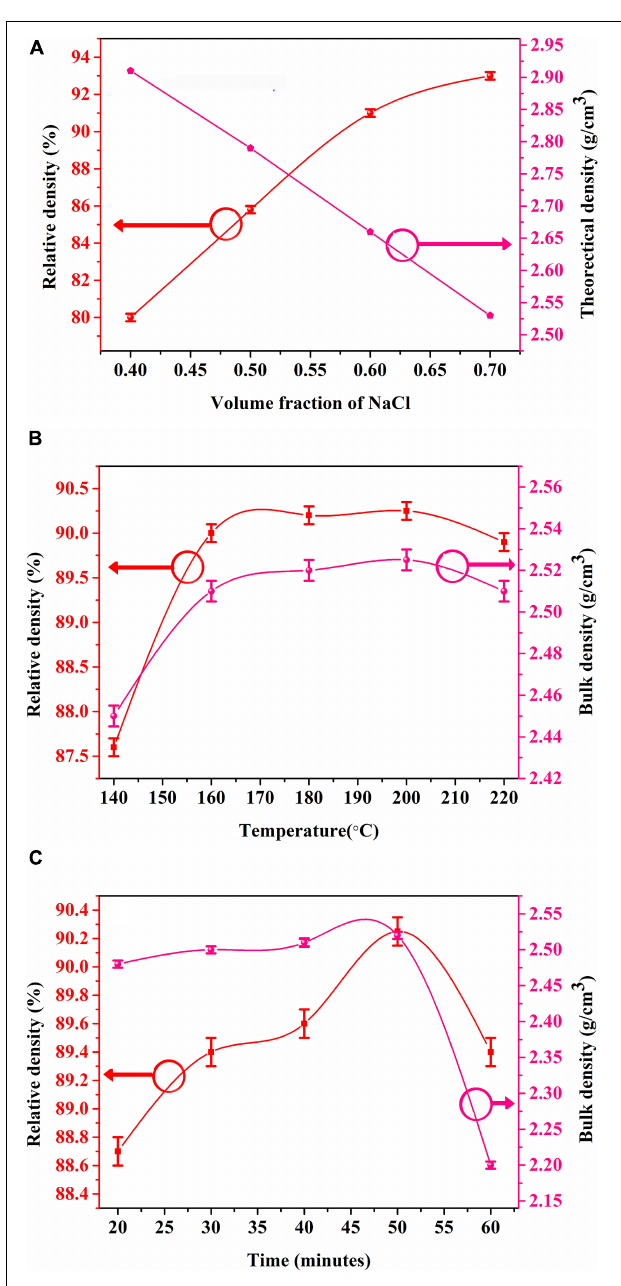
FIGURE 1 | Dependence of Bulk density and relative density of (1 – x )NCMVO-xNaCl composite with (A) volume fraction of NaCl, (B) temperature, and (C)